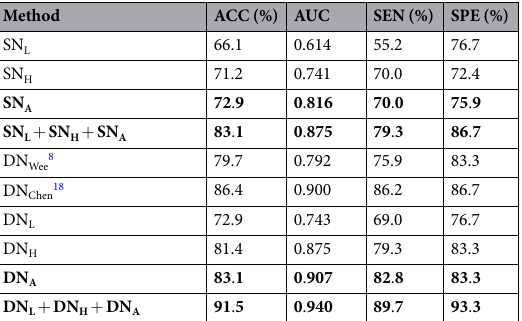
Table 1. Performance comparison among the methods using different FC networks for eMCI